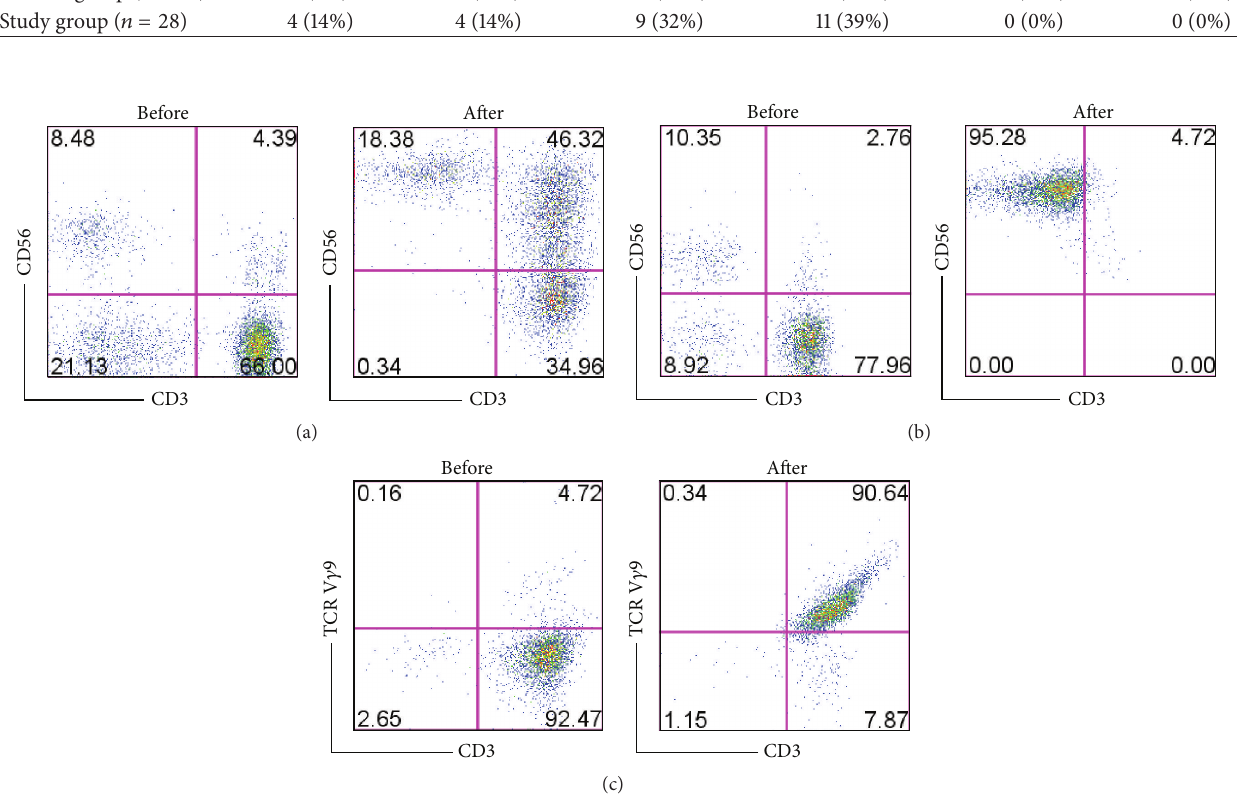
Figure 2: (a) The percentage of CIK cells including (CD3+ CD56+), (CD3+ CD56 − ), and (CD3 − CD56+) before and after induction and CD4+ and CD8+ before and after induction in one of the patients. (b) The percentage of NK cells (CD3+ CD56 − ) before and after induction and the activated NK (CD56+ CD69+) before and after induction in one of the patients. (c) The percentage of 𝛾𝛿 T before and after induction in one of the patients.